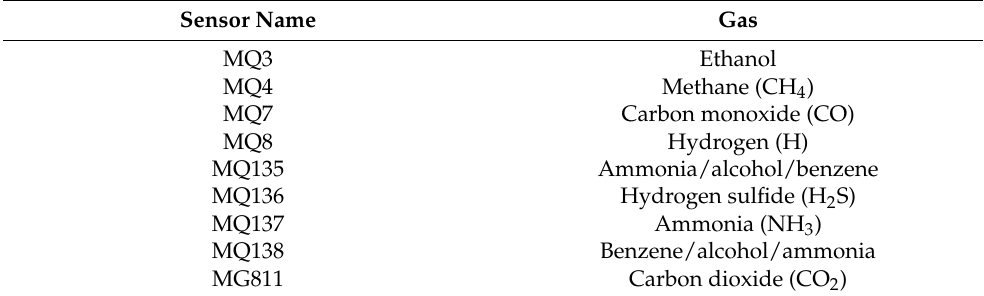
Table 2. Sensors included in the electronic nose and the gases to which they are